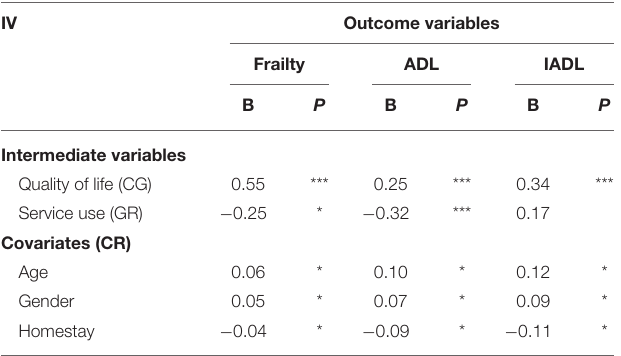
TABLE 4 | Path analysis—function of health outcomes variables.